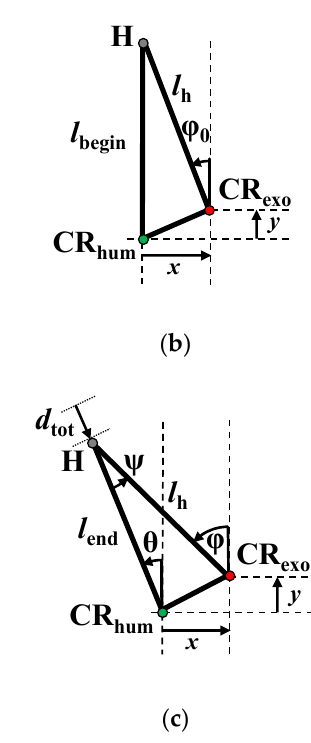
Figure 2. Analytical model of a robot with joint misalignment. ( a ) A model of a robot with misalignment; ( b ) the beginning of the movement process, at θ = 0; ( c ) the end of the movement process, at θ = θ end .